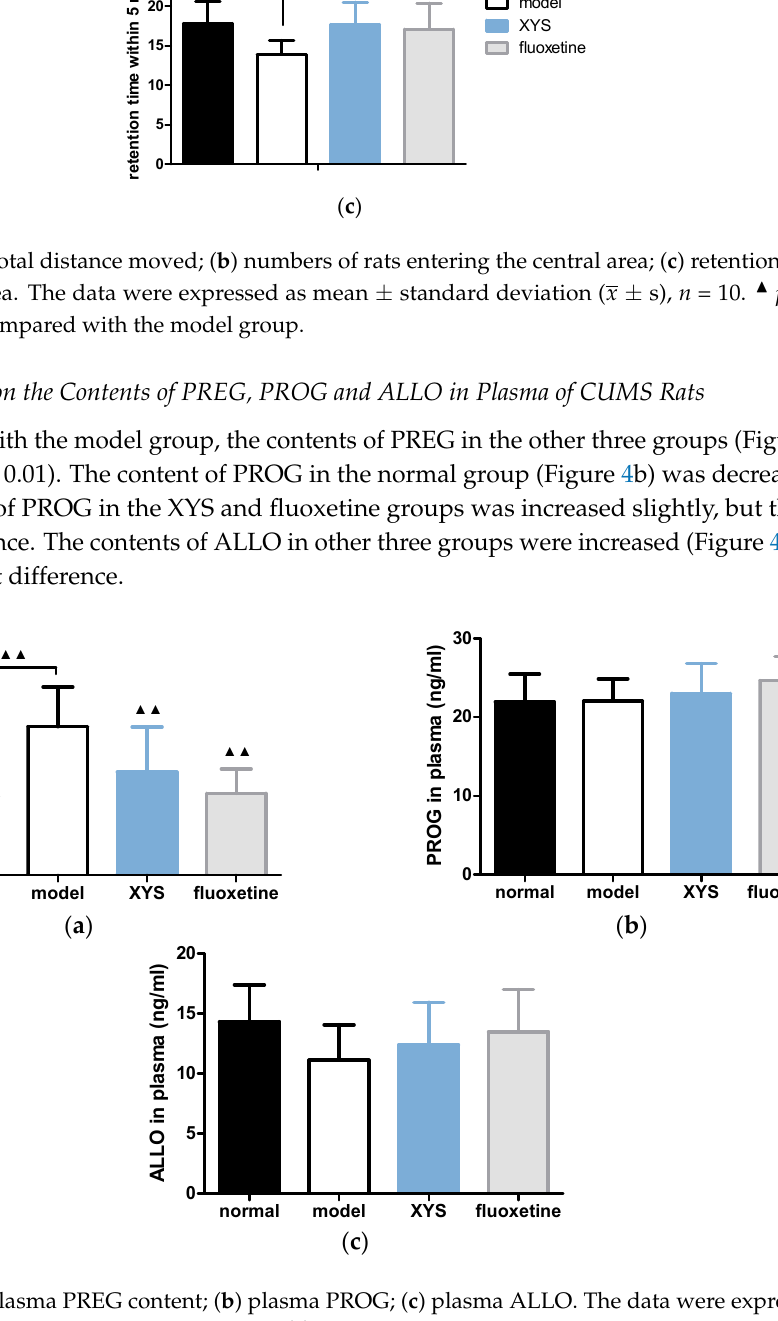
Figure 4. ( a ) Plasma PREG content; ( b ) plasma PROG; ( c ) plasma ALLO. The data were expressed as mean ± standard deviation ( (cid:1876)̅ ± s), n = 10. ▲▲ p < 0.01, compared with the model group.